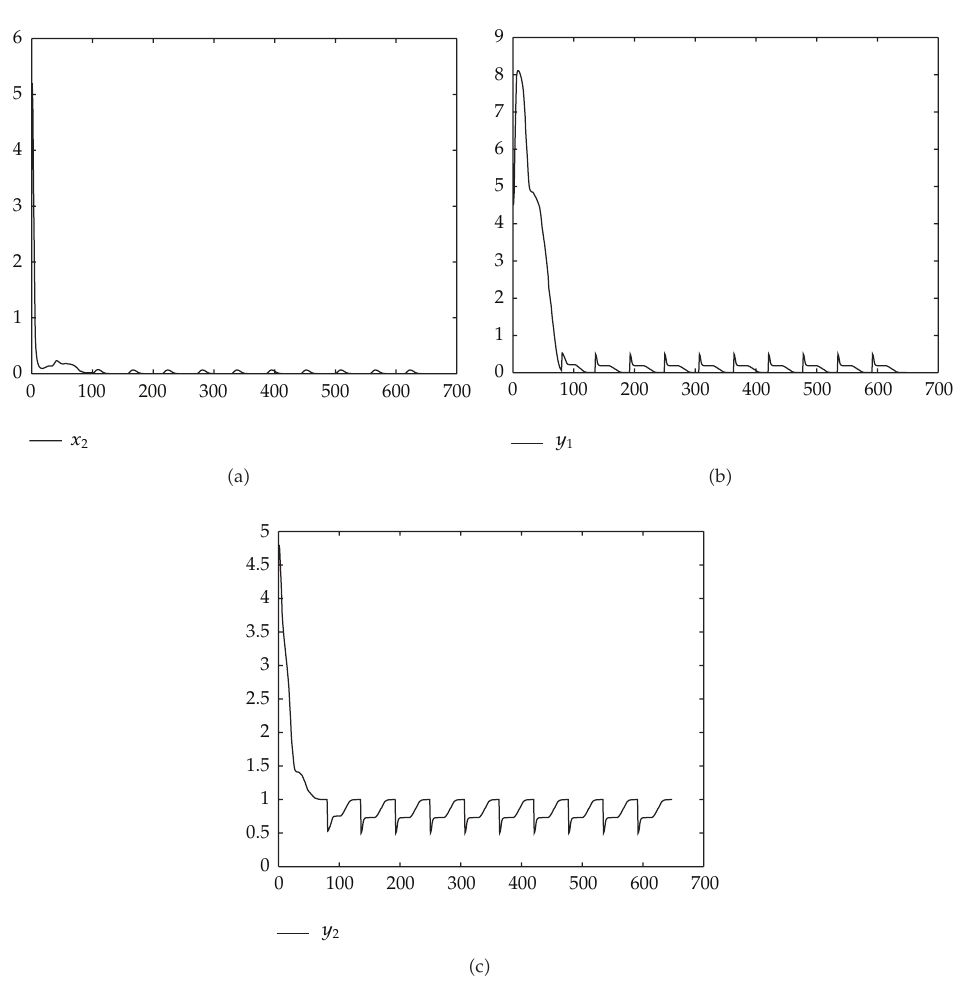
Figure 2: Dynamical behavior of the permanence of system (cid:5) 2.5 (cid:6) with x 2 (cid:5) 0 (cid:6) (cid:8) 5 . 2, y 1 (cid:5) 0 (cid:6) (cid:8) 5 . 0, y 2 (cid:5) 0 (cid:6) (cid:8) 5 . 6, τ 1 (cid:8) 1, d (cid:8) 3, a 1 (cid:8) 1, a 2 (cid:8) 1, b 2 (cid:8) 1 β (cid:8) 4, k (cid:8) 0 . 9, D (cid:8) 0 . 5, w (cid:8) 1, and τ (cid:8) 1 . (cid:5) a (cid:6) Time-series of x 2 (cid:5) t (cid:6) . (cid:5) t (cid:6) . (cid:5) c (cid:6) Time-series of y (cid:5) t (cid:6) (cid:5) b (cid:6) Time-series of y 1 2